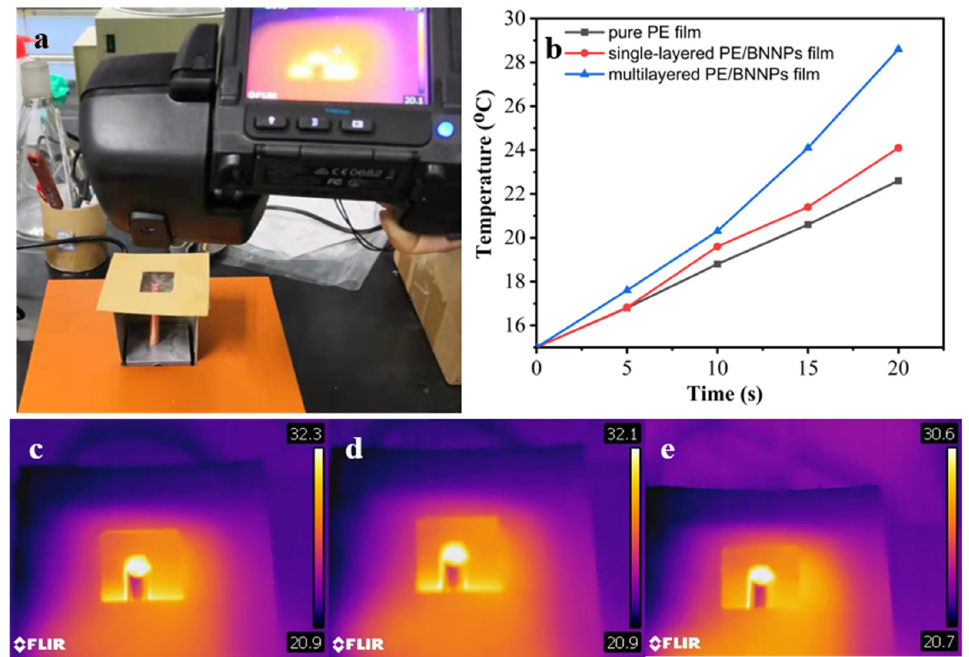
Figure 7. Infrared thermography characterization of the samples to confirm the improvement of in-plane thermal conductivity with the addition of BNNPs intuitively. ( a ) The experimental setup for the infrared thermography. ( b ) Temperature rise at the edge of different films. ( c – e ) Steady- state temperature distribution of pure PE film, single-layered PE/BNNPs film, and multilayered PE/BNNPs film,